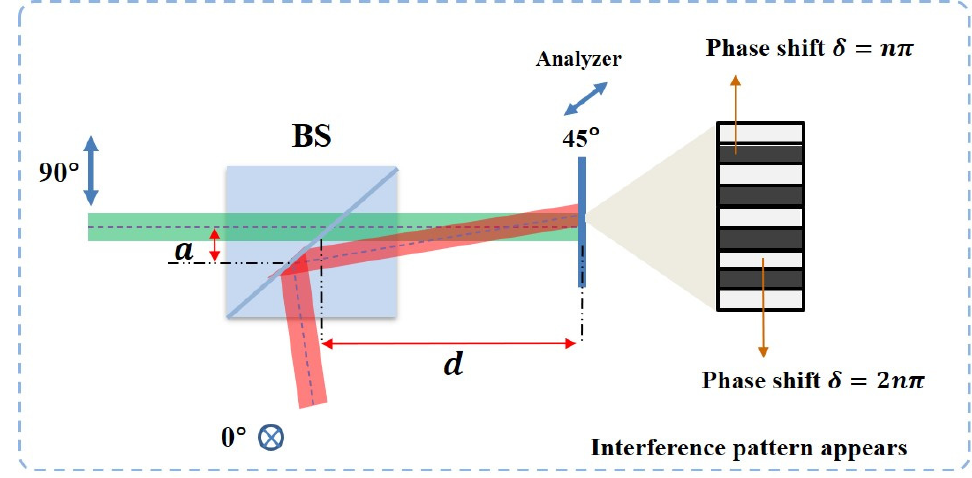
Figure 10. When two basis vector beams have an alignment error, two orthogonal vector beams will have a small angle at the image reconstruction plane. Due to the high coherence of two beams, they will spatially interfere. Therefore, the interference fringes can be observed under an analyzer.